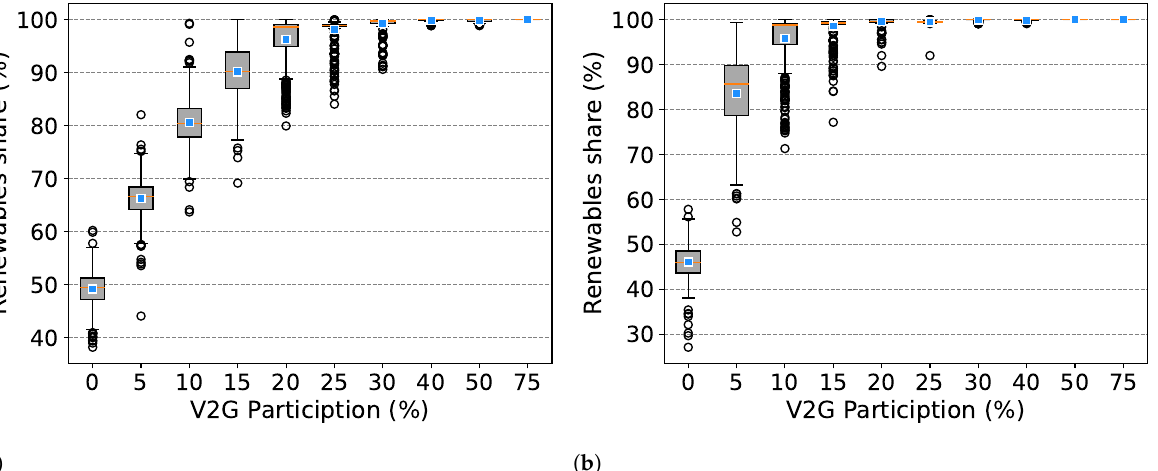
Figure 8. Share of renewables in the Berlin LORs with V2G application. ( a ) Summer case. ( b ) Winter